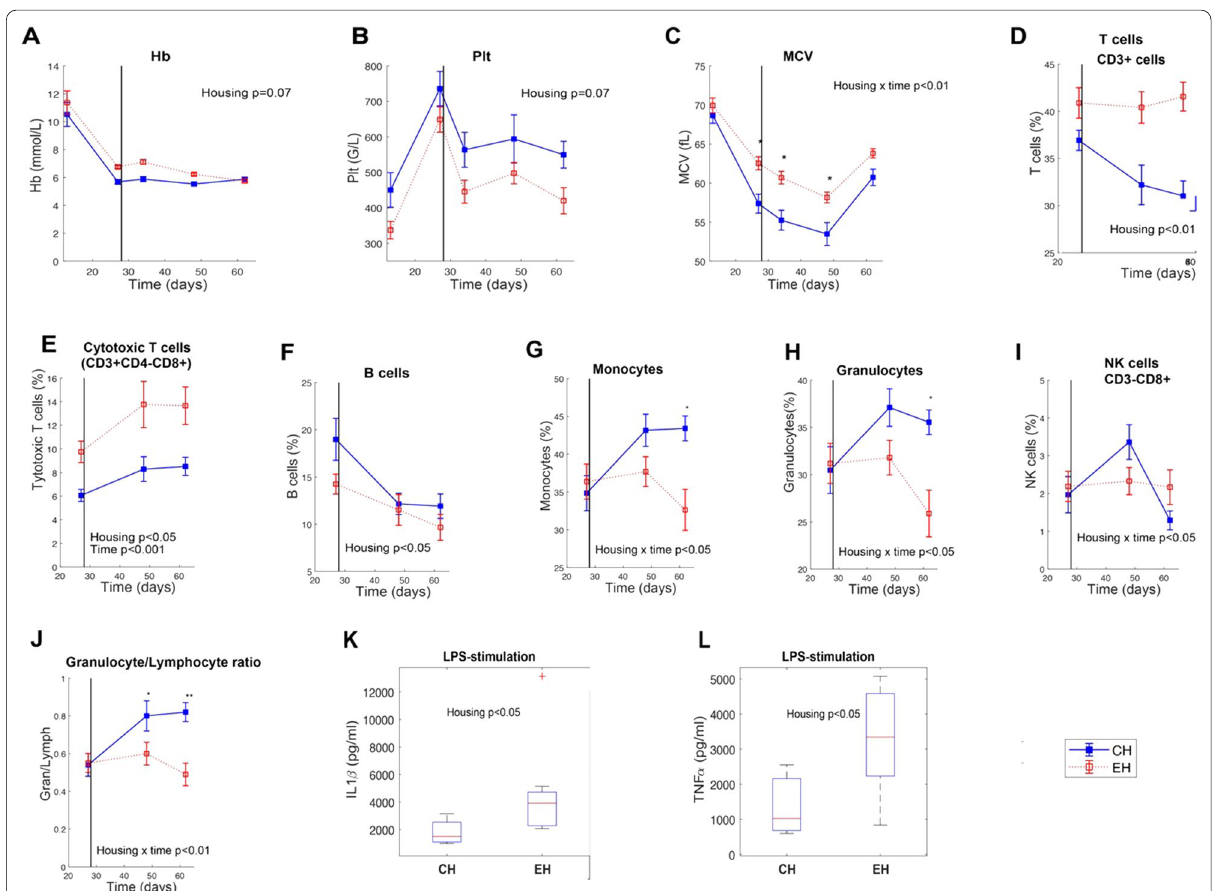
Fig. 3 The effect of housing condition on cell blood count, leukocyte subpopulations and whole blood stimulation assay. A – C represent haemoglobin (Hb), platelet (Plt) and mean corpuscular volume (MCV), respectively. D – I sequentially show the leukocyte subpopulations of the total T cells, cytotoxic T cell, B cells, monocytes, granulocytes and NK cells. J expresses the ratio of granulocyte/lymphocyte (Gran/Lymph). K , L exhibits the difference between both housing conditions in the level of IL1ß and TNF‑α after lipopolysaccharide (LPS) challenge for the whole blood stimulation assay. ‘*’ and ‘**’ indicate significant differences for conventional housing (CH) vs. enriched housing (EH) pigs (post hoc comparison, * p < 0.05, ** p <